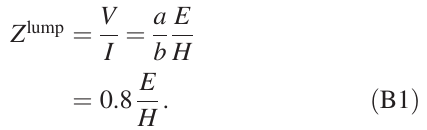
Fig. 21. The reflection coefficients remain below − 20 dB around the operating frequency.